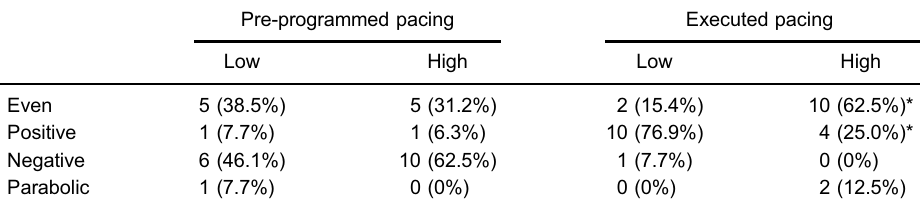
Table 3. Pre-programmed and executed pacing in low- and high-performance race